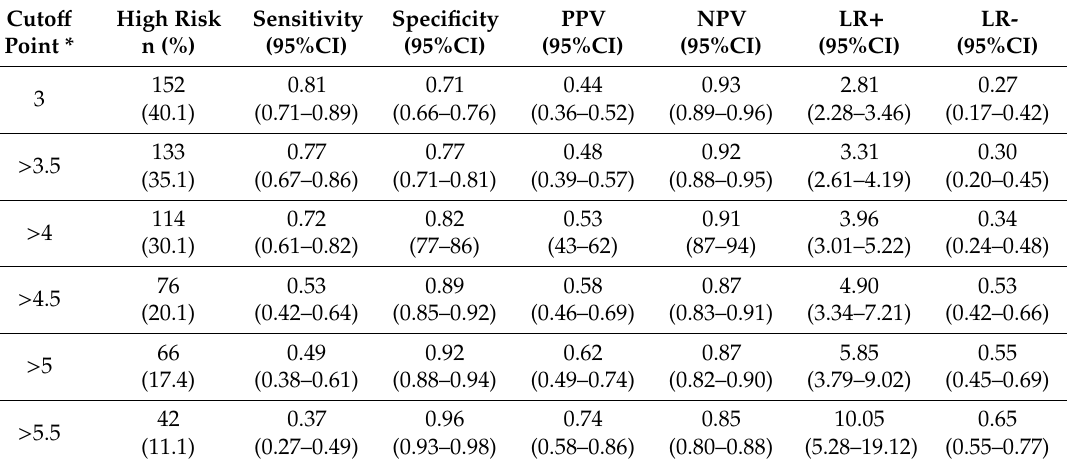
Table A2. Performance of the risk scores at di ff erent cuto ff points